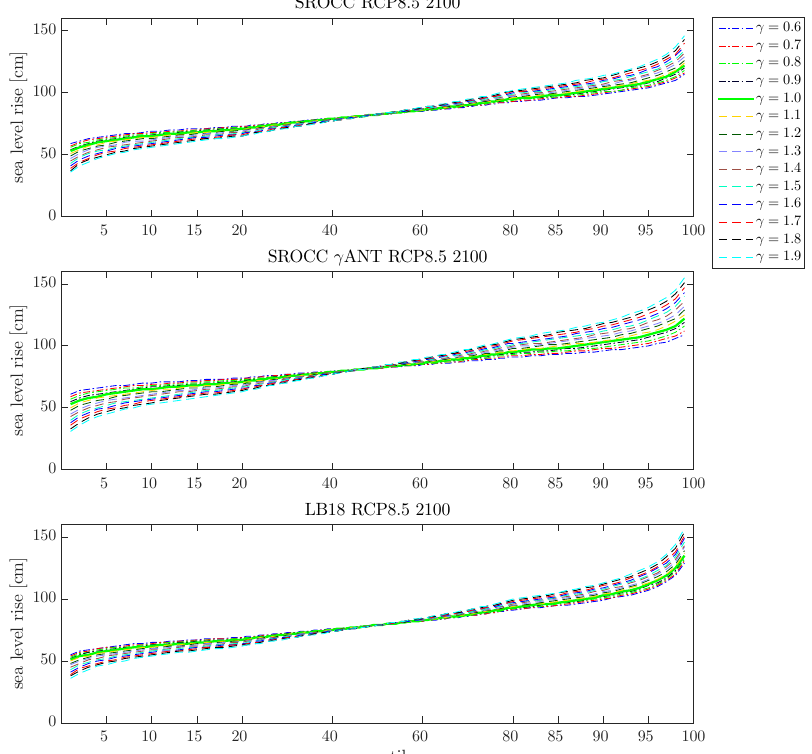
Figure 6. The sea level projections for RCP8.5 as a function of γ in the two models. In the middle panel, we introduced the γ ANT parametrisation, where not only the GMST distribution but also the Antarctic distribution is multiplied by γ . The x -axis is stretched for percentiles smaller than 20 and larger than 80. At those percentiles, the distance plotted between consecutive percentiles is twice that used in the range between the 20th and 80th